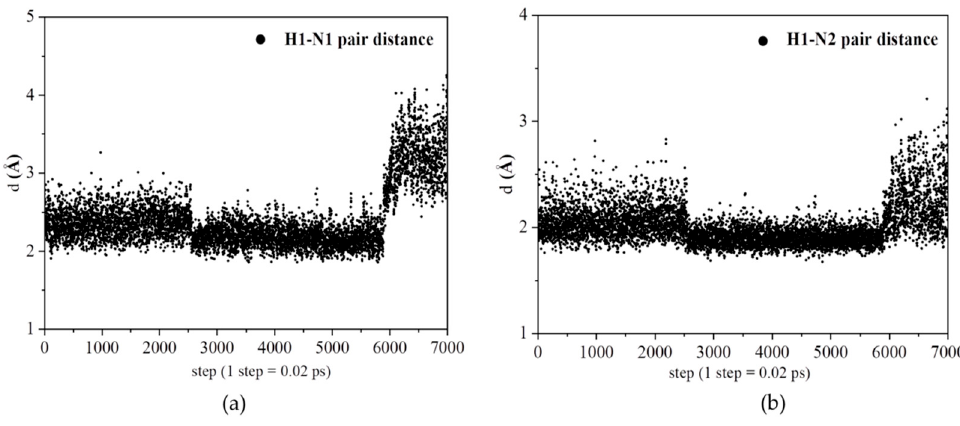
Figure 7. ( a ) The relative distance of a selected proton with N1 (N1 in Py). ( b ) The relative distance of a selected proton with N2 (N2 in Py).